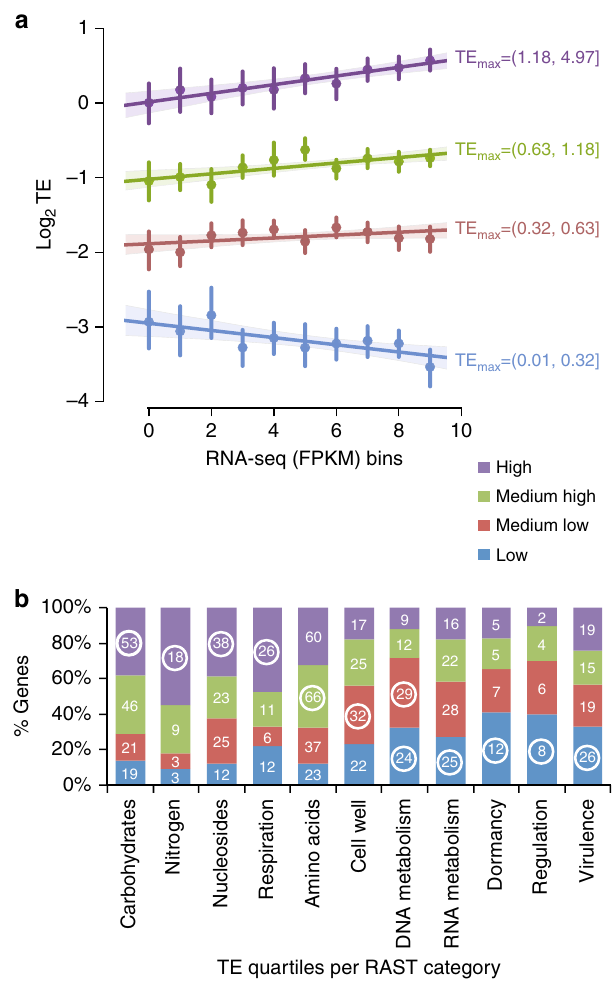
Fig. 6 mRNA features and transcription levels determine the dynamics of differential TE. a Scatter plot between log 2 TE as four quartiles on the Y axis and RNA-seq (FPKM) values grouped into ten bins on the X axis. TE max cutoffs are shown next to each regression with the same color codes. The dots represent the mean of TE in each RNA-seq category. The vertical lines over each dot represents 95% con fi dence intervals of each bin. The linear regression lines are fi tted with shadowed regions representing 95% con fi dence intervals. b Stacked barplot demonstrating the enrichment of genes in RAST categories within each TE max quartile (shown as percent) with the same color codes as in ( a ). The white numbers represent gene counts for each TE max quartile in a given RAST category. Signi fi cantly enriched quartiles (Fisher exact test) are indicated with circled gene